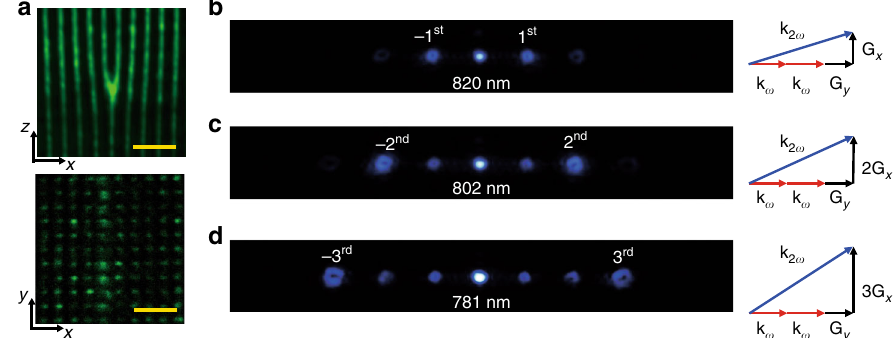
Fig. 2 Far- fi eld diffraction patterns of the 3D nonlinear fork-grating array. a The 3D NPC structures in the x – z and x – y planes through a confocal SH microscopic system (the length of scale bars, 10 μ m). b – d SH diffraction patterns and their corresponding QPM con fi gurations. The ±1st, ±2nd, and ±3rd diffraction orders are enhanced through noncollinear QPM processes at the input wavelengths of 820 nm, 802 nm, and 781 nm, respectively. In our experiment, G x = G y = 2 π /3 μ m − 1 . The 0th-order SH beam is brighter than high-order diffraction beams because of larger interaction volume in a collinear SH generation